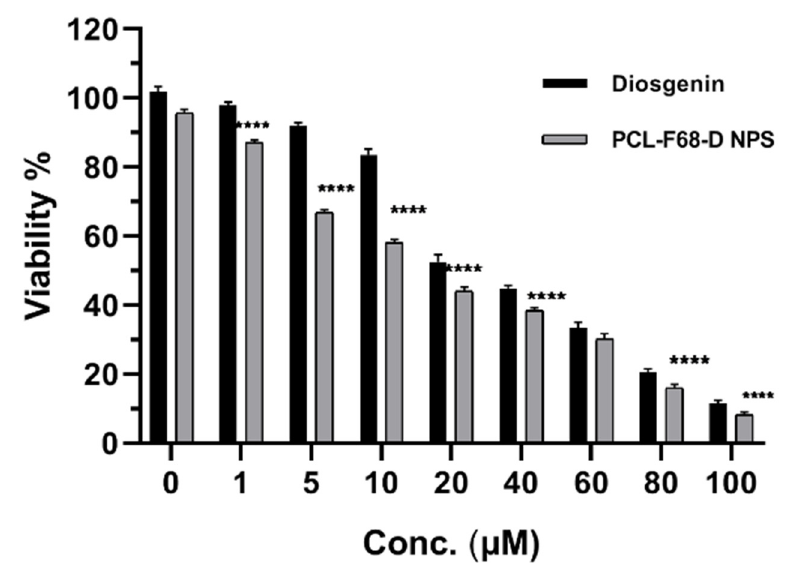
Figure 6. U87-MG glioblastoma cell cytotoxicity profile. MTT assay of Diosgenin and Diosgenin-